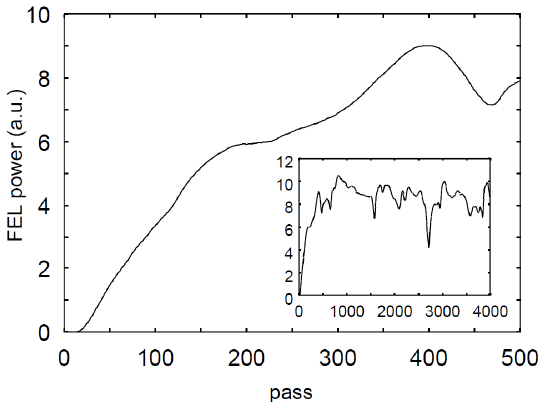
Figure 3. Numerical result for the JAERI-FEL start up simulation. Evolution of an FEL macropulse calculated with the JAERI-FEL parameters at δ L = 0 lasing is plotted. Whole structure of macropulse is also shown in the inset